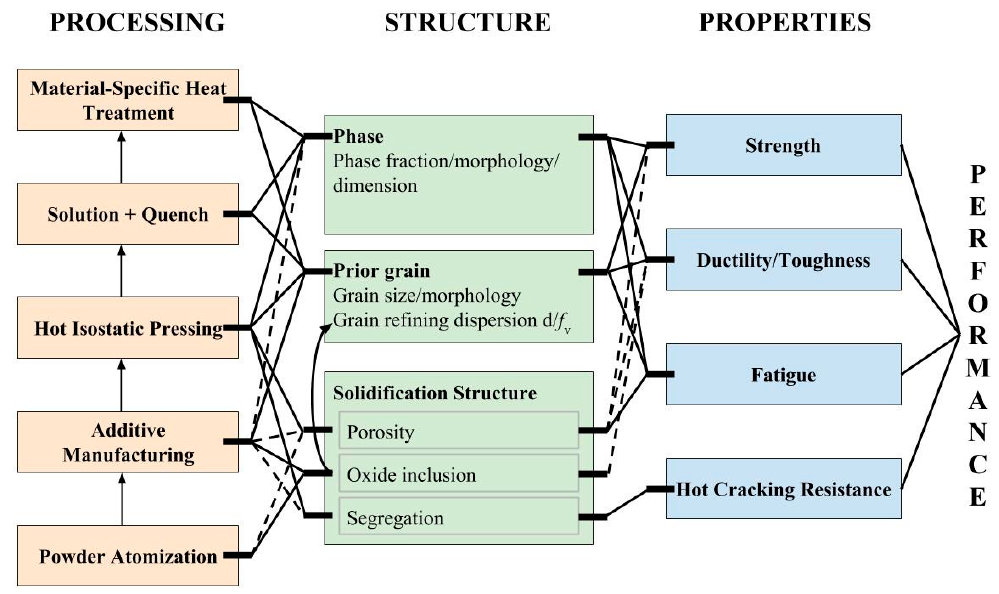
Figure 1. Systems design chart outlining the major process-structure-property-performance relationship for general metallic materials produced by powder-based additive manufacturing. Dash lines